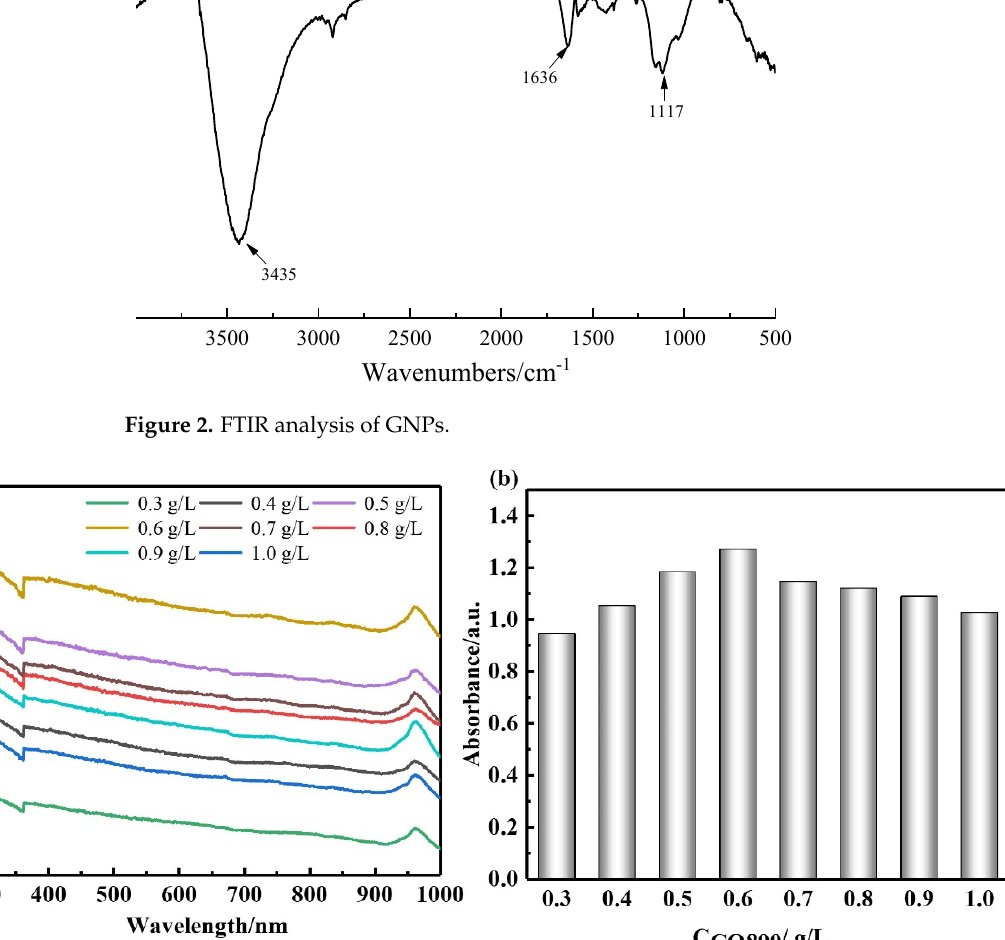
Figure 4. SEM of GNPs: ( a ) before dispersion; ( b ) after dispersion. Figure 5. TEM images of GNPs after dispersion. 3.2. Macro Performance Figure 6 shows the mechanical properties of the SAC paste. The addition of dispersed GNPs improves the mechanical properties of the SAC paste. The compressive strengths of the G0, G1, G2, and G3 groups after curing for 28d were 81.5 MPa, 89.7 MPa, 96.8 MPa,